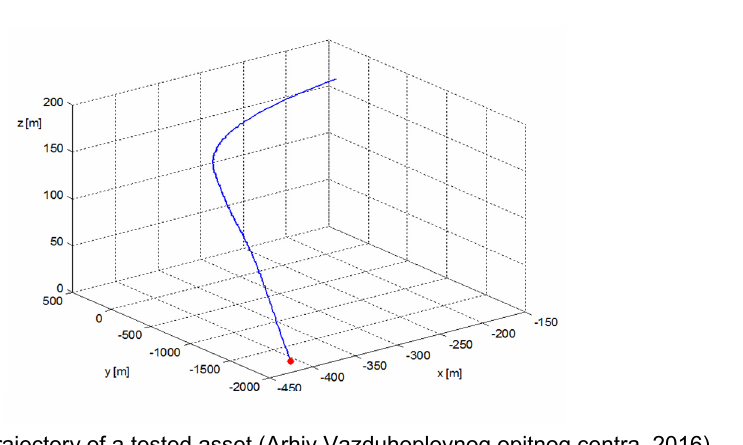
Figure 11 – Trajectory of a tested asset (Arhiv Vazduhoplovnog opitnog centra, 2016) Рисунок 11 – Изображение траектории исследуемого объекта (Arhiv Vazduhoplovnog opitnog centra, 2016)